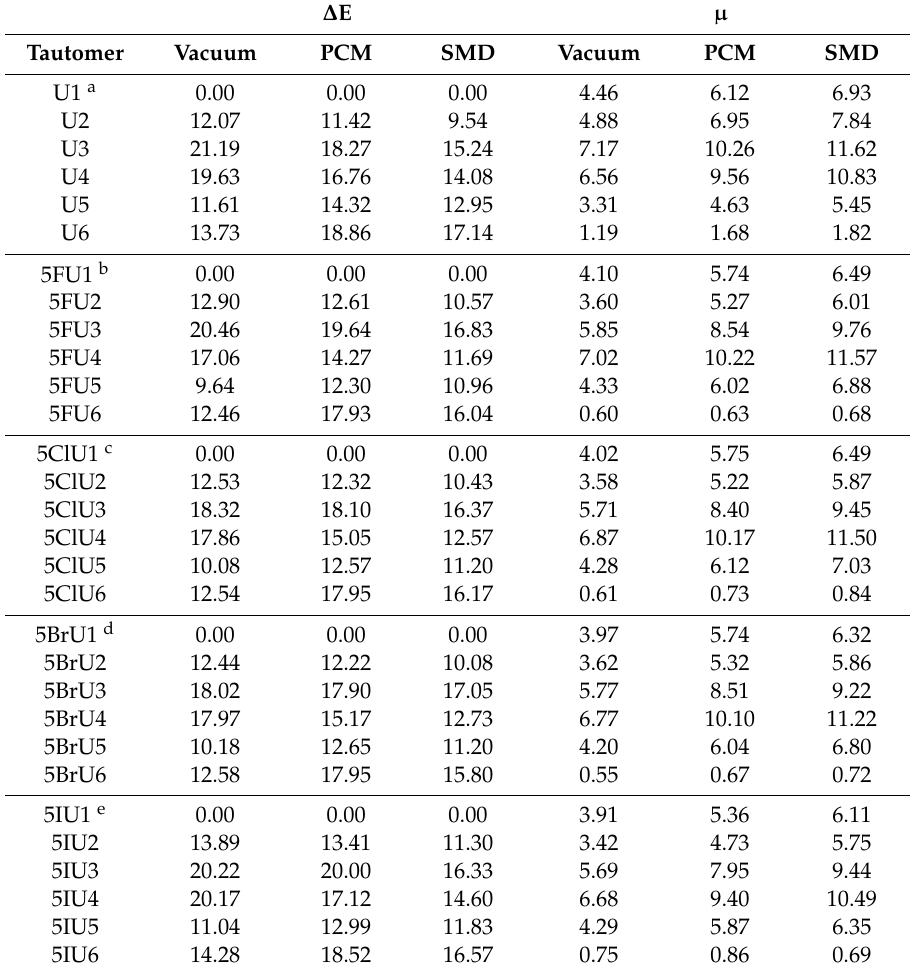
Table 1. B3LYP-D3 / aug-cc-pVQZ calculated relative energies ( ∆ E in kcal / mol), and dipole moment ( µ in D) of uracil tautomers and its 5-halogeno derivatives in the gas phase and water using the polarizable continuum model (PCM) and the solvent model density